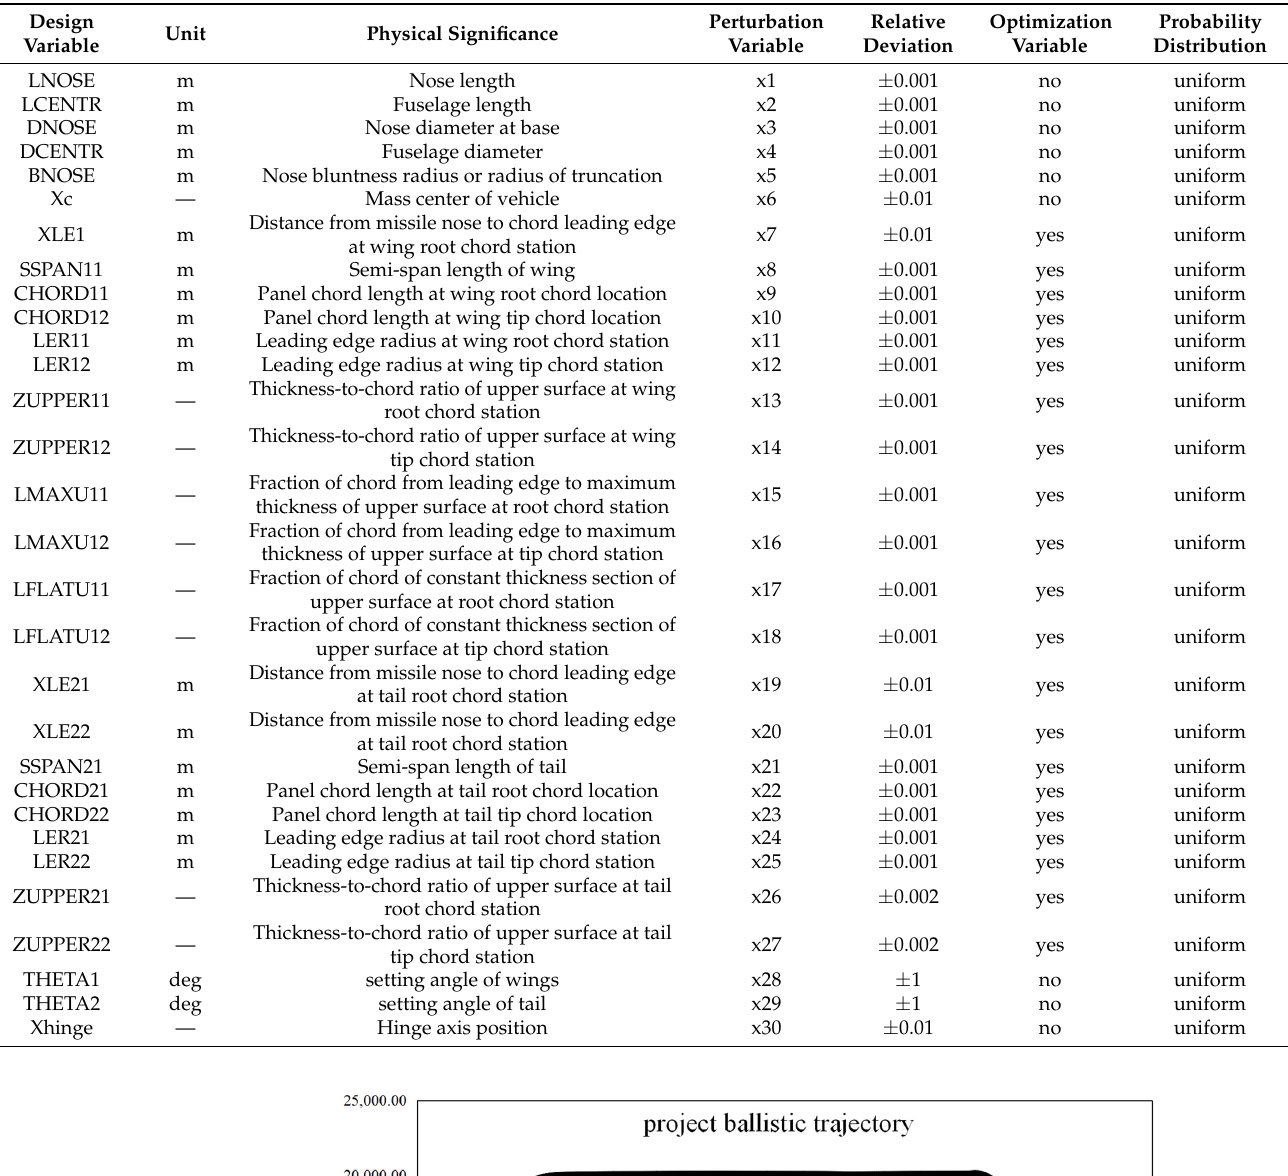
Table 1. Parametric modeling of vehicle.